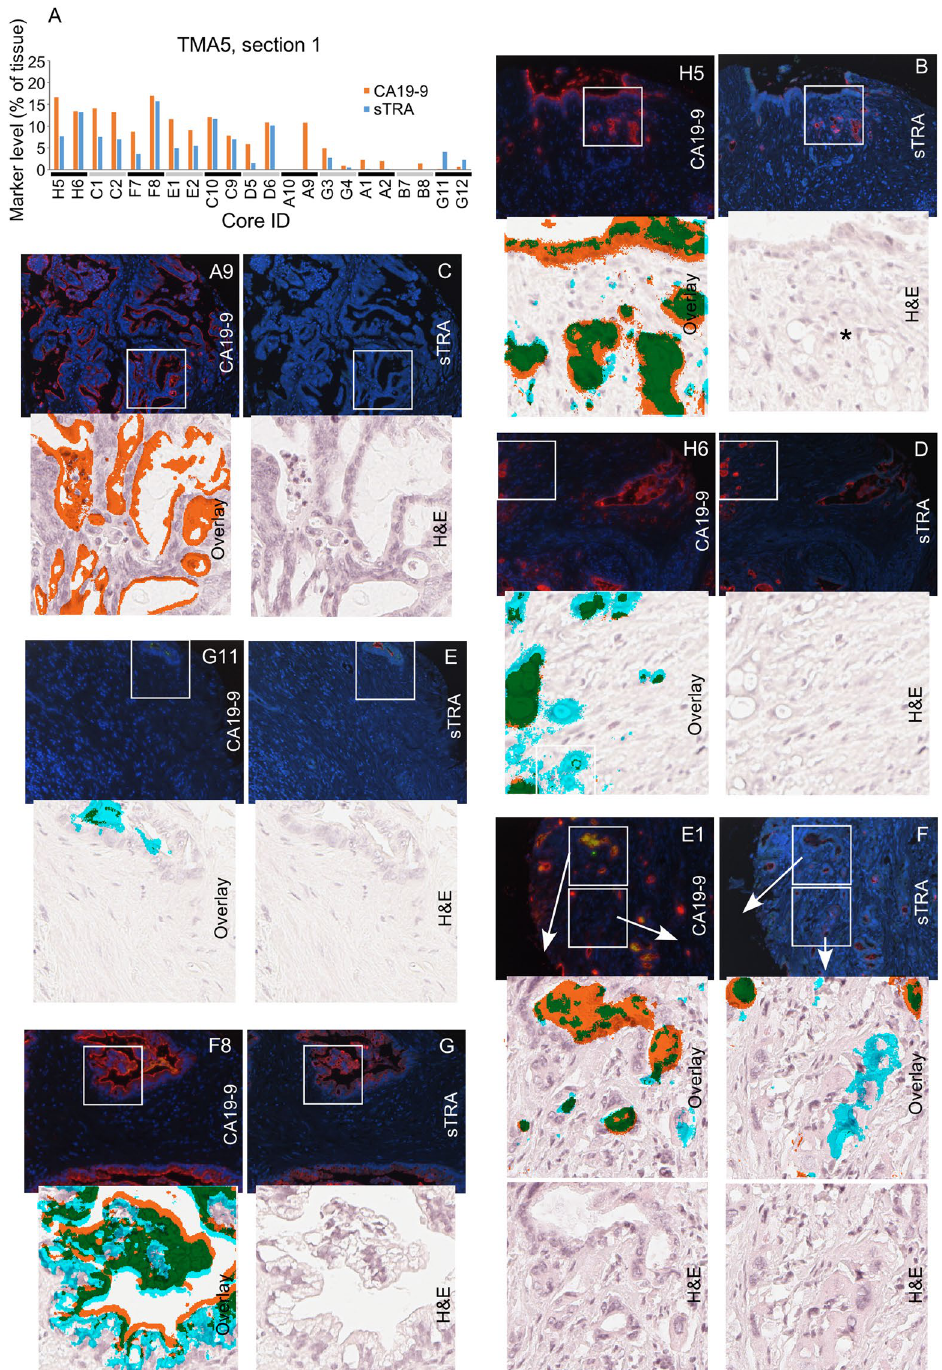
Figure 3. Cellular morphologies associated with each glycan. ( A ) The cores had various levels of each antigen. The TMA contained two cores from each tumor, presented in pairs in the column graph. ( B – G ) The top two images in each group are the raw fluorescence from the second (left) and third (right) rounds of immunofluorescence. The red signal in the left image is CA19-9, and the red signal in the right image is sTRA. The lower images in each group are zoomed pictures corresponding to the white box. The lower left image is the H&E image overlaid with the detected signals. The signal from CA19-9 is orange, the signal from sTRA is cyan, and the overlapping signal is green. The lower right image is from the H&E stain. The asterisk in panel B marks vacuolated, invasive